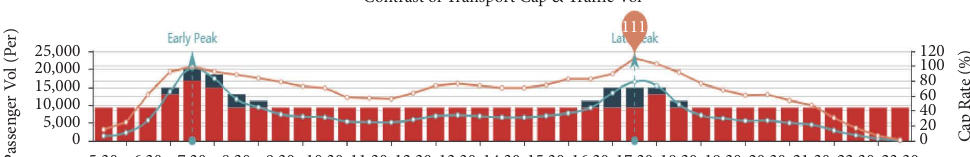
Figure 11: Contrast of transport capacity and trafc